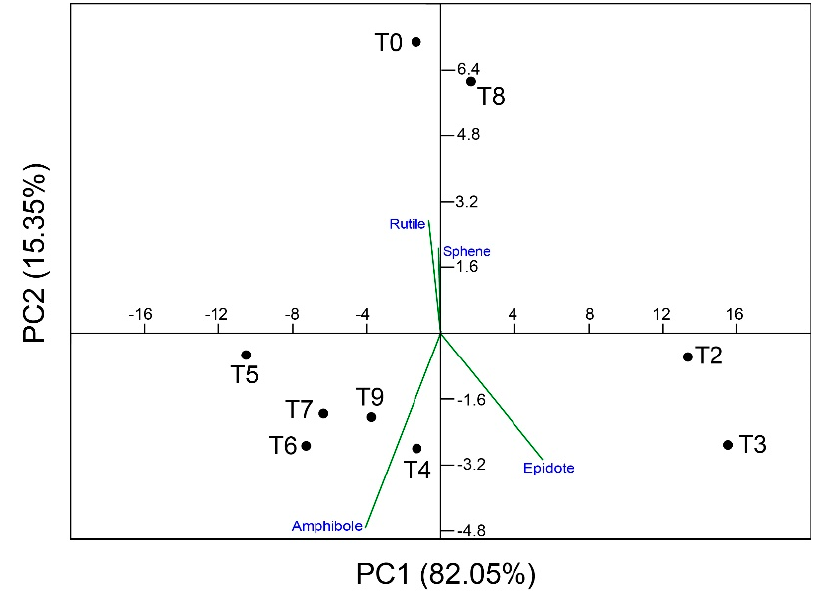
Figure 6. Principal component analysis of heavy-mineral assemblages in Yellow River terraces of the Lanzhou area.